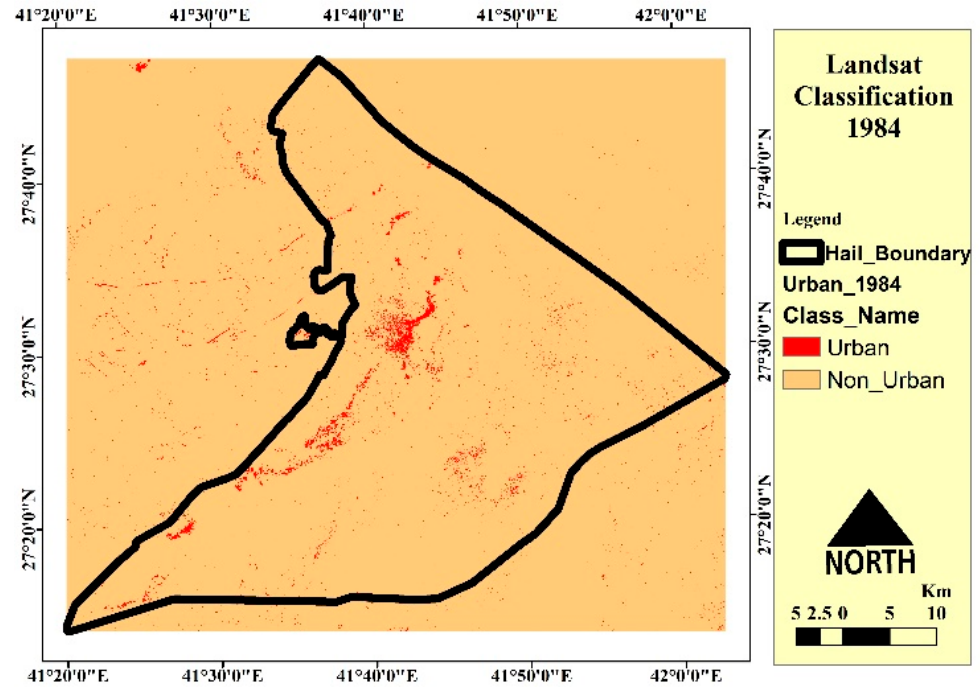
Figure 6. Landsat classification for an urban area, 1984.